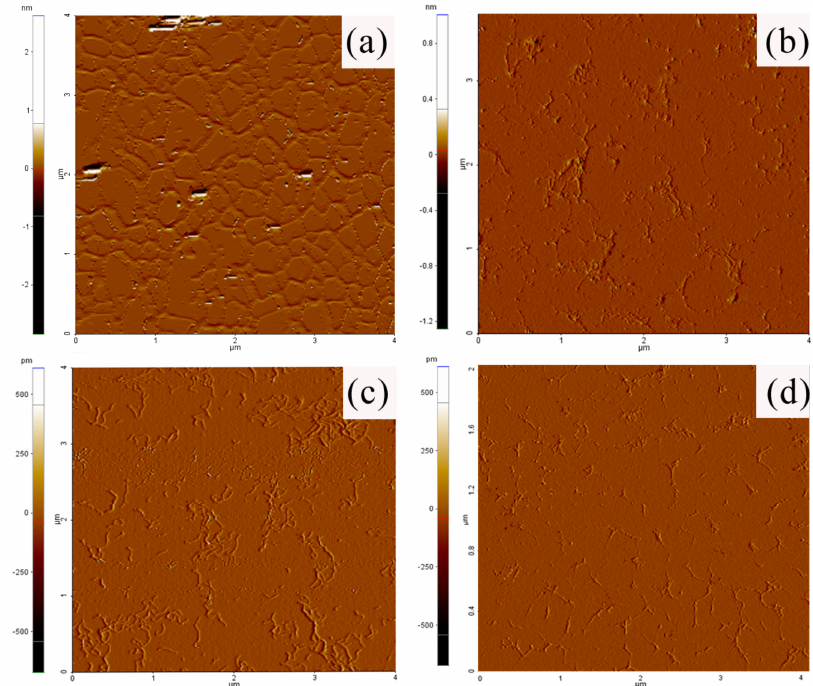
Figure 6. Atomic force microscopy (AFM) analysis of xanthan and xanthan digests. ( a – d ) AFM topography images of xanthan, xanthan hydrolyzed by Mi Xen–CD, xanthan hydrolyzed by Mi Xen– CBMx, and xanthan hydrolyzed by Mi Xen–CBM84, respectively.